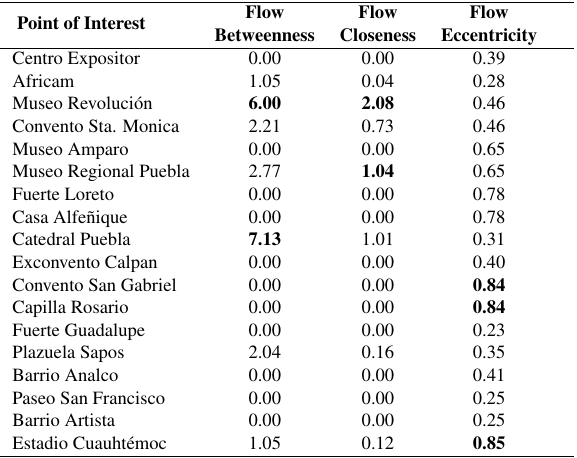
Table 2: Centrality computation